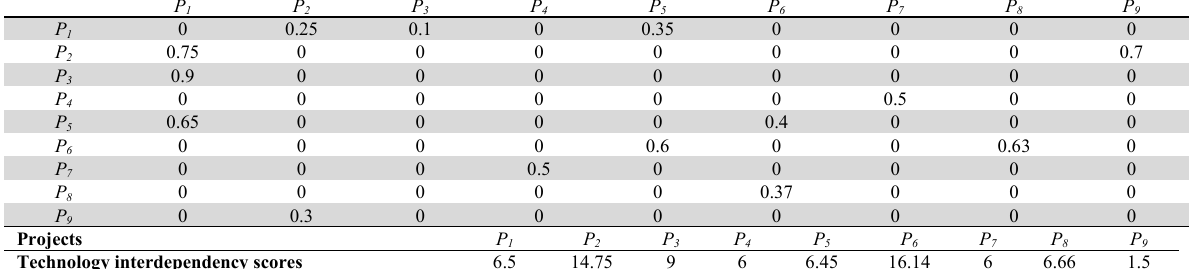
r’ ij values matrix of projects